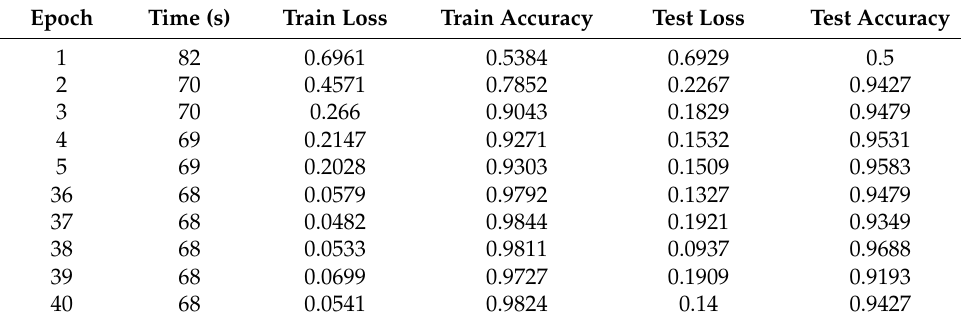
Table 2. Results obtained after training was